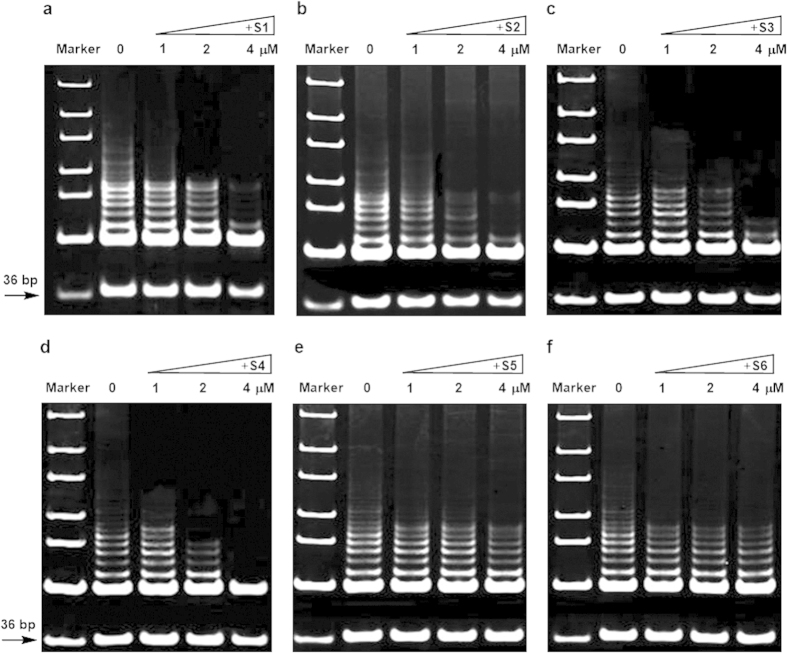
Effect of benzothioxanthene derivatives on the telomerase activity in SGC7901 cells.Cell extracts containing telomerase and TRAP assay reagents were mixed and the activity of telomerase was determined in the presence of 0, 1, 2, or 4 μM S1–S6 (a–f). The arrow indicates the 36 bp internal control.